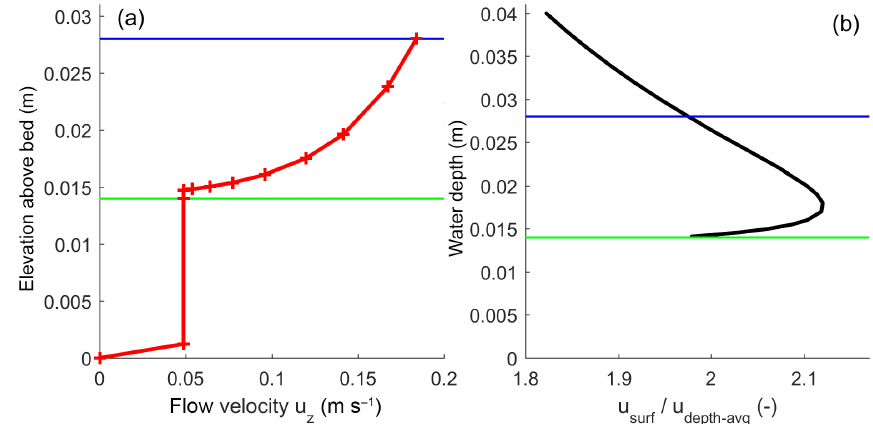
Figure 4. Application of the Baptist et al. (2006) vegetation friction relation to the artificial vegetation in the Metronome. (a) Flow velocity profile (red) between the bed and the water surface (blue). Height of vegetation indicated in green. (b) Ratio between water surface velocity u surf and depth-averaged velocity u depth − avg as a function of total flow depth. This is independent of slope. Given the insensitivity to water depth variations, a constant value of 1.95 is assumed for comparison of measured and modelled flow